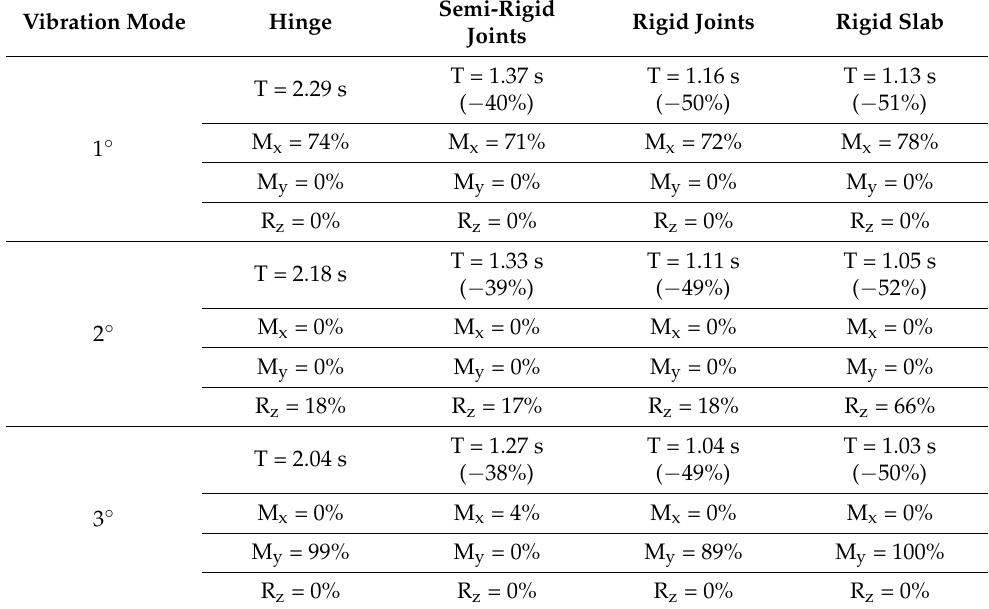
Table 3. Modal analysis results.